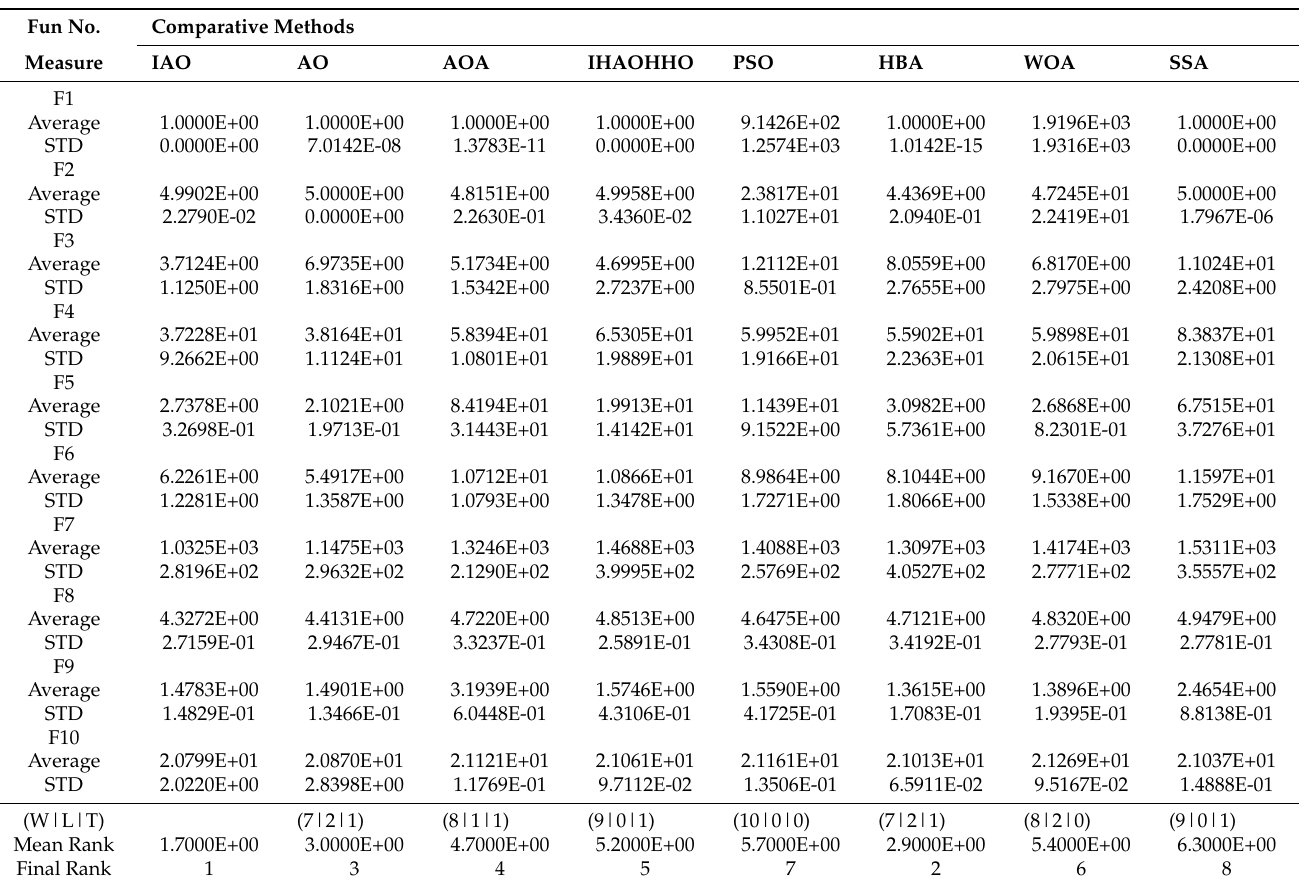
Table 12. Results of the comparative methods on CEC2019 test